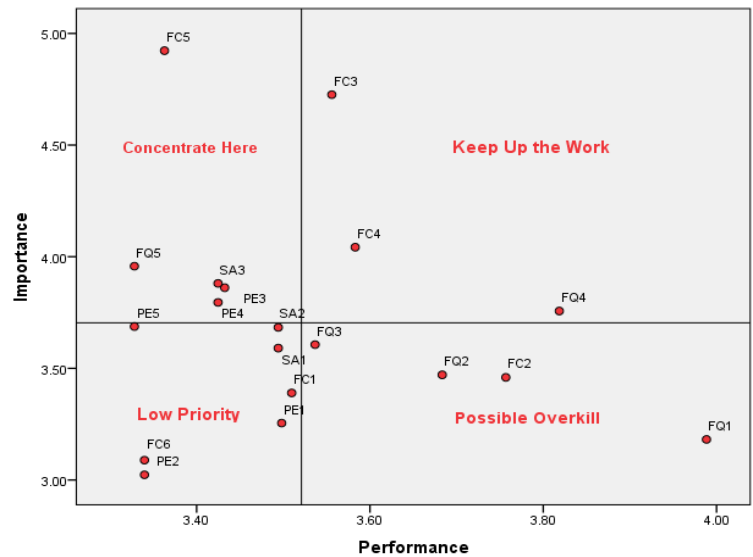
Figure 2. Results of IPA analysis for attributes.